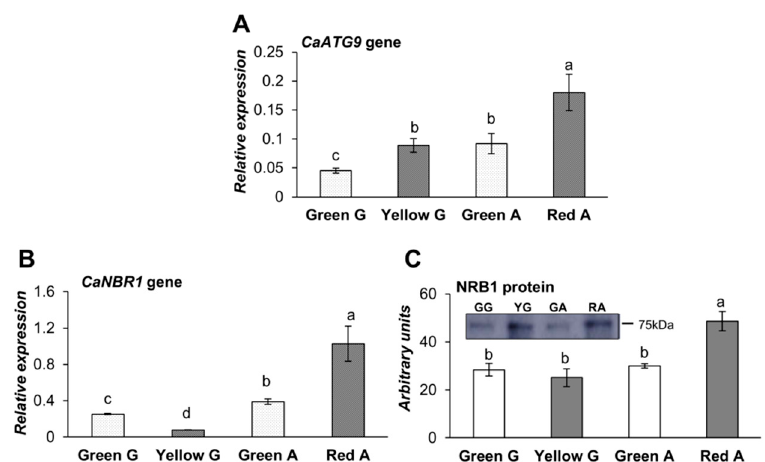
Figure 4. Expression analysis of ( A ) CaATG9 , ( B ) CaNBR1 genes relative to ACTINE-100 by RT-qPCR, and ( C ) Western blot analysis of the CaNBR1 protein in green Galena (GG) and yellow Galena (YG), green Alonso (GA), and red Alonso (RA) pepper fruits. Data are means ± standard error (SE) of three technical replicates of three biological samples. Different lower case letters indicate that data are significantly different according to the Kruskal-Wallis test at p < 0.05.